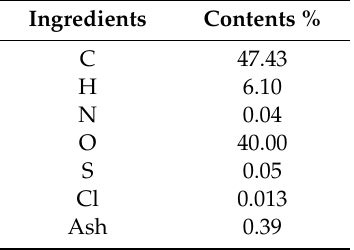
Table 2. Elemental composition of the